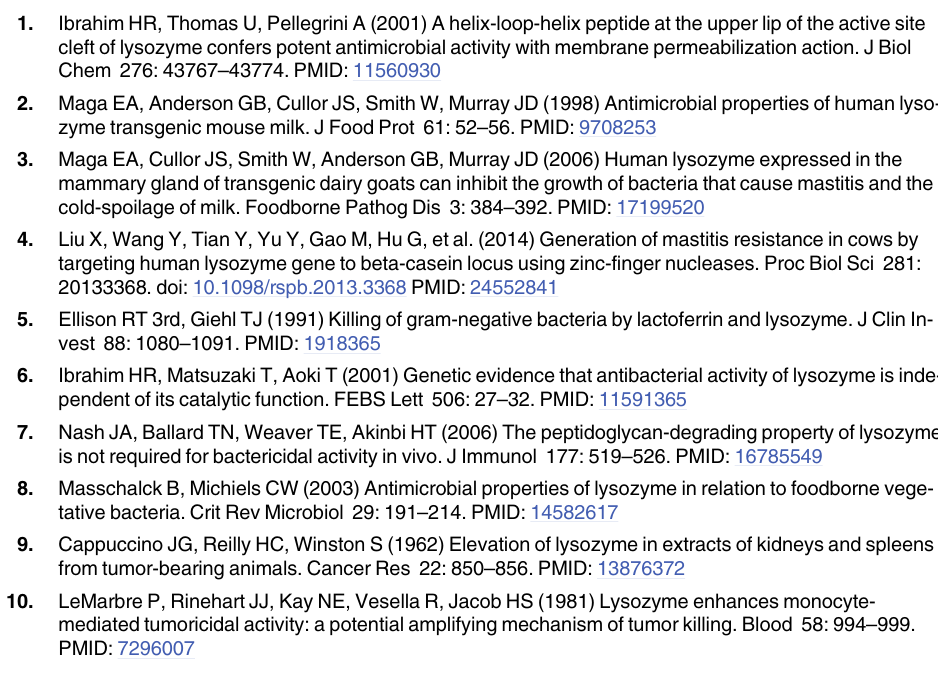
S1 Table. Primers for transgenic pigs verification. (cid:2) All the primers were uesed to detected rhLZ mice and pigs in our previous studies[24,26]. S2 Table. Expression level of rhLZ in the milk of transgenic pigs (mg/L) and rhLZ enzymat- ic activities (U/ μ L) of milk collected on day 7. Values are averages ± standard deviations. Some samples at particular time were not collected, and here we use “ - ” to indicate. S3 Table. The influence of rhLZ transgenic milk on the growth of Escherichia coli K88 . Val- ues are averages ± standard